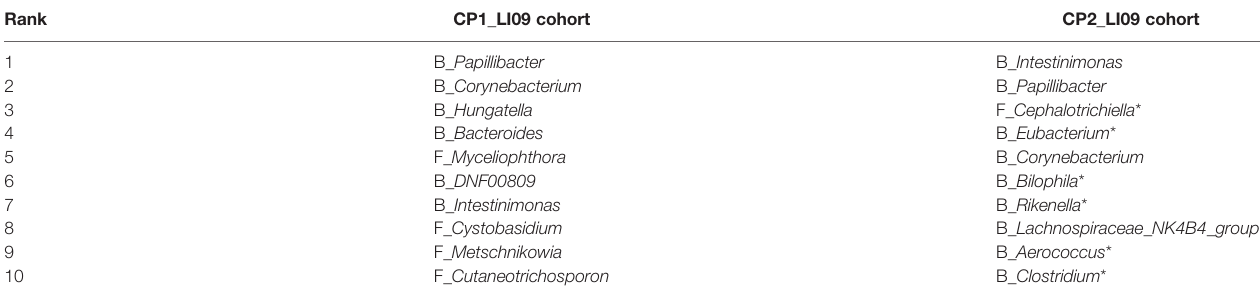
“ B_ ” and “ F_ ” represent the microbes belonging to bacteria and fungi, respectively. Rank represents the rank of correlation number. *Represents the microbes with most correlations found in CP2_LI09 cohort but not CP1_LI09 cohort.